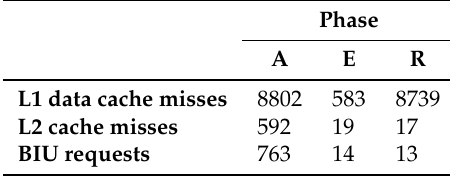
Figure 12. Benchmark for evaluation. Table 2. Benchmark measurement results per phase.